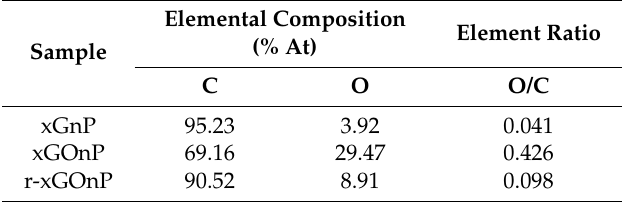
Table 1. XPS analysis results for xGnP, xGOnP, and